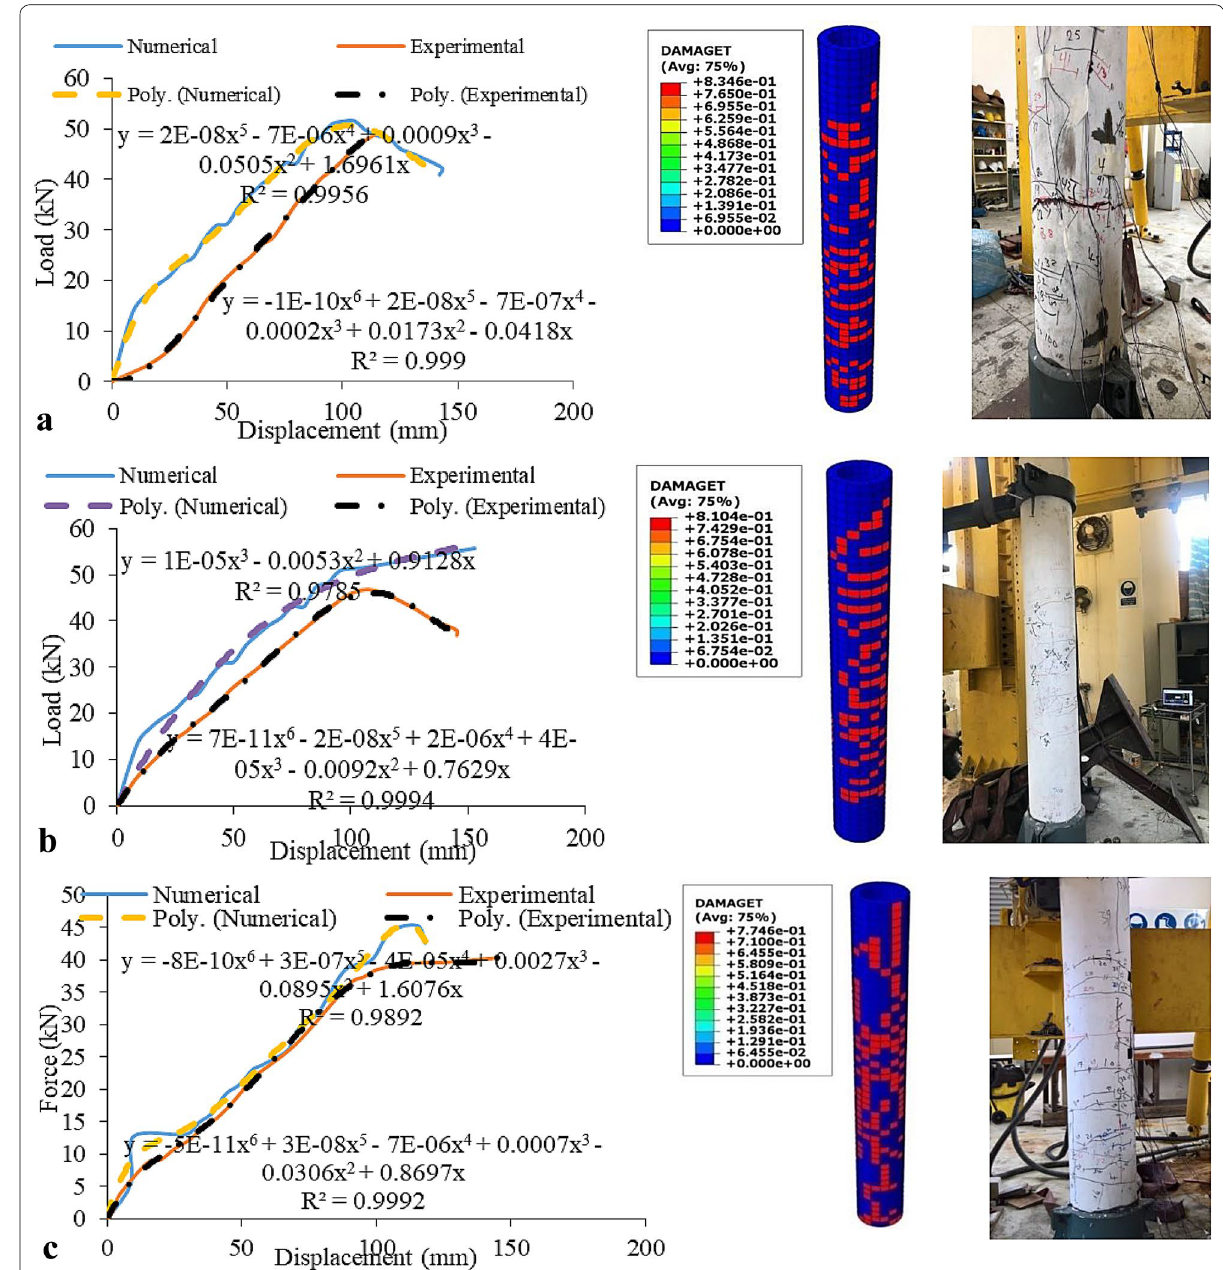
Fig. 21 Load-deflection curves obtained from the numerical model and test results at top of the columns a C1, b C2 and c